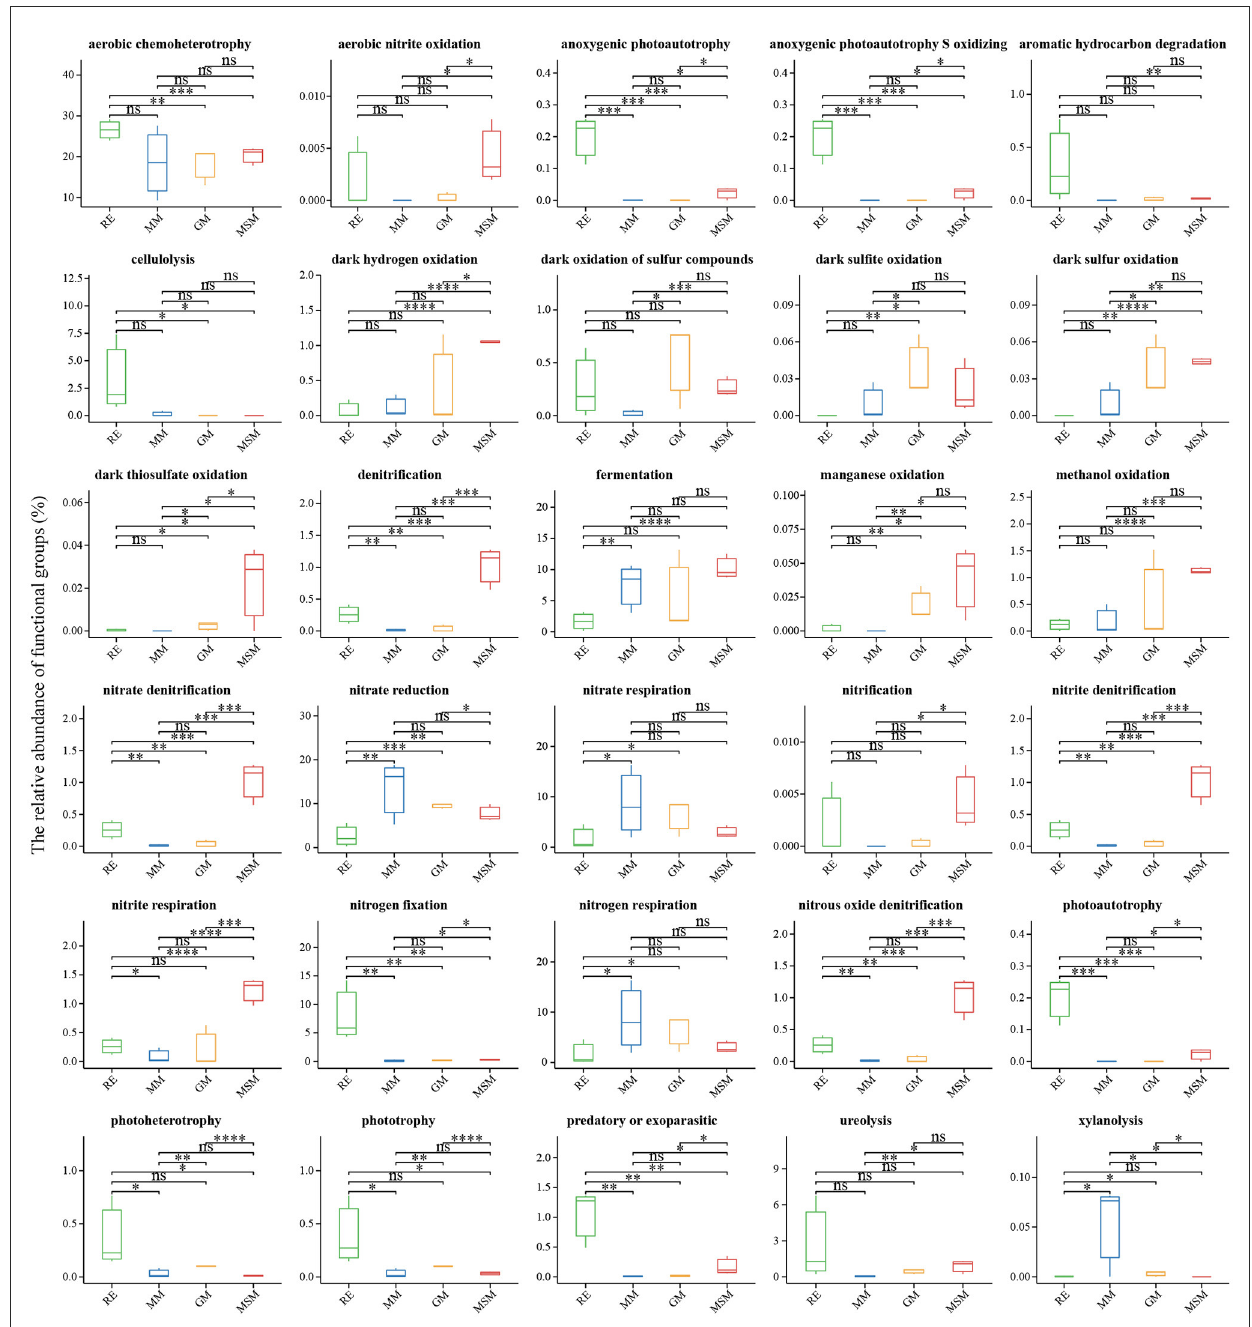
FIGURE5 Functional prediction of the bacterial communities in all experimental groups using FAPROTAX. The results revealed the significant differences in the potential functions of the bacterial communities between the in situ samples and the enrichment collections. * Correlation is significant at the 0.05 level; ** Correlation is significant at the 0.01 level; *** Correlation is significant at the 0.001 level; **** Correlation is significant at the 0.0001 level. Table 1 presents a list of abbreviations of the groups used in the